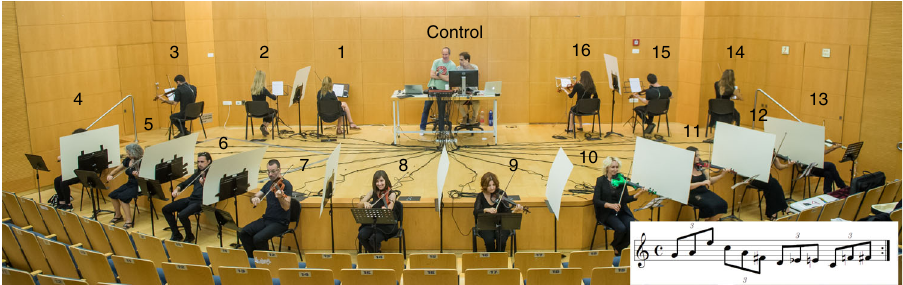
Fig. 1 Sixteen coupled electric violin players repeating a musical phrase. Sixteen violin players are playing with electric violins. The audio output from each violin is connected to our computer-controlled mixing system. Then, the mixing system sends to the headphones of each player a sum of audio signals of the desired connectivity, strength, and delay. All participants in the picture have approved publishing it. The musical phrase is presented in the inset.